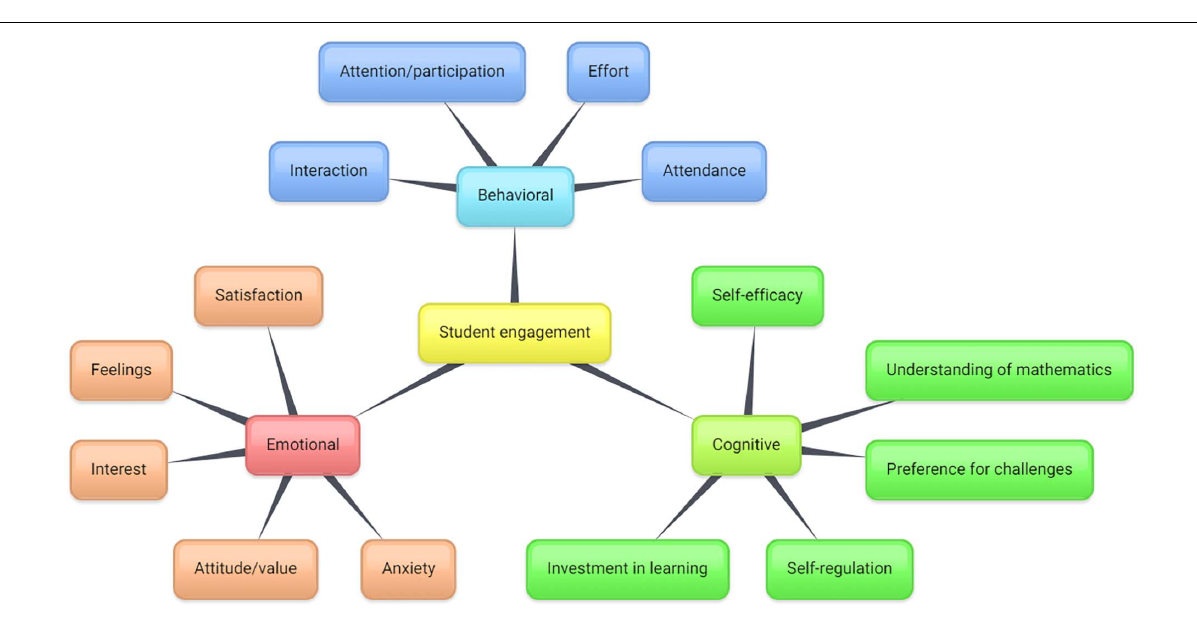
FIGURE 2 | Dimensions of student engagement covered in the included studies. B, Behavioral engagement; E, Emotional engagement; C, Cognitive engagement.